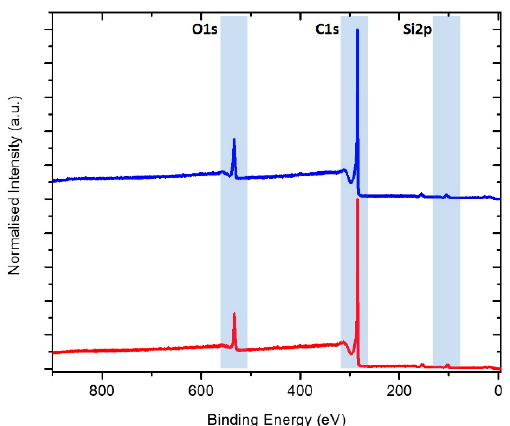
Figure 3. XPS survey spectra of Si/MC powders before (blue) and after HF etching (red). Blue-marked areas show the regions used for quantification as shown in Table.